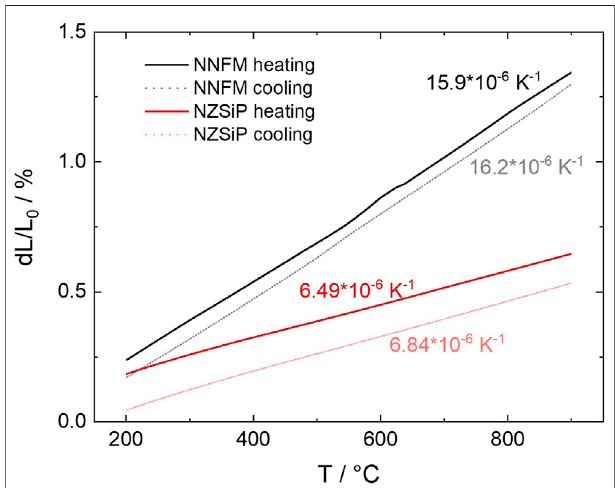
FIGURE 4 | Dilatometry of NNFM (black) and NZSiP (red) from 25 to 1,200 ° C with heating and cooling rate of 3 K/min and 30 min holding time at 1,200 ° C in air. CTE determined between 200 and 900 °